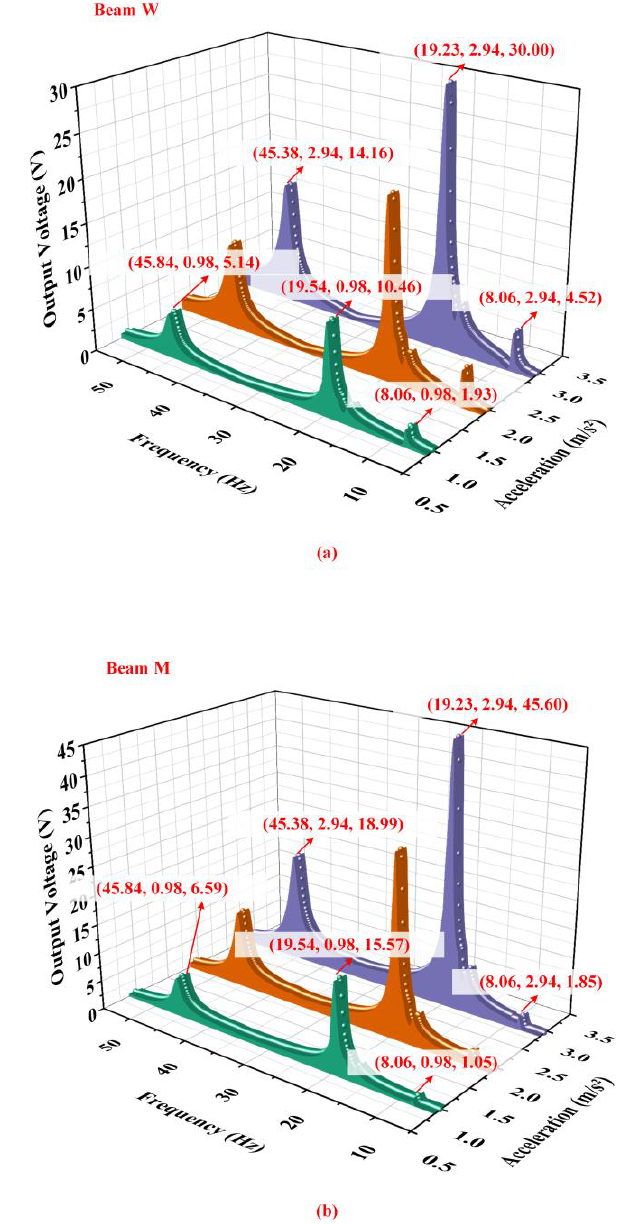
Figure 7. The output voltage of ( a ) beam W and ( b ) beam M under different accelerations by ex- periment.